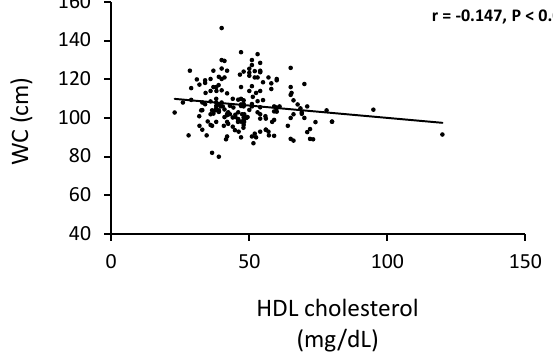
Figure 2. Correlation between HDL cholesterol and body mass index for pre ( n = 100) and postmenopausal ( n = 88) women.